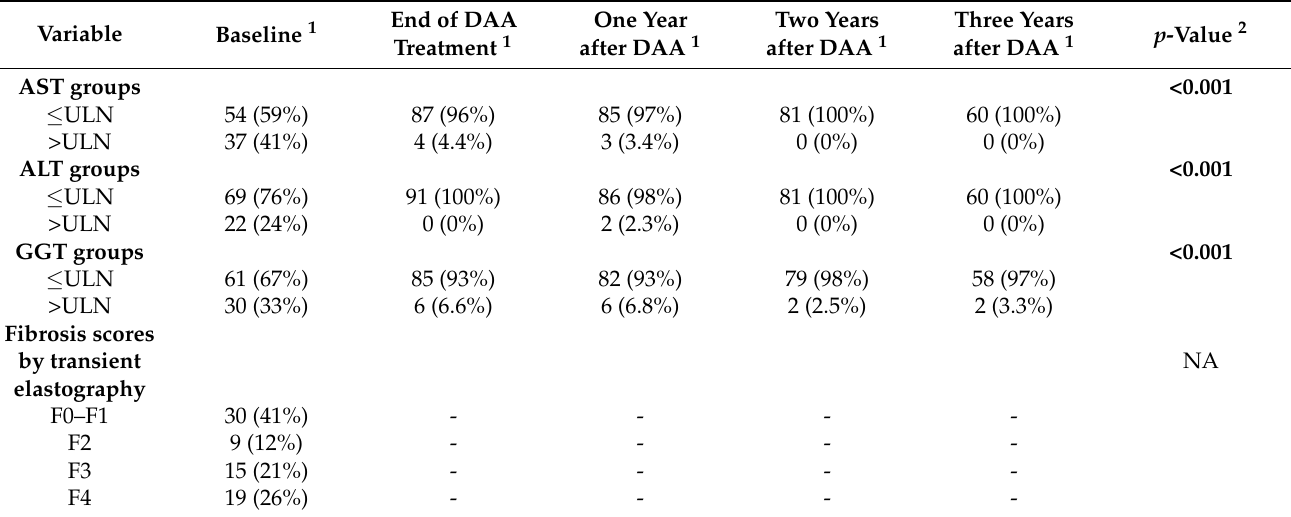
Table 2. Liver TE (baseline only) and enzymes over follow-up time